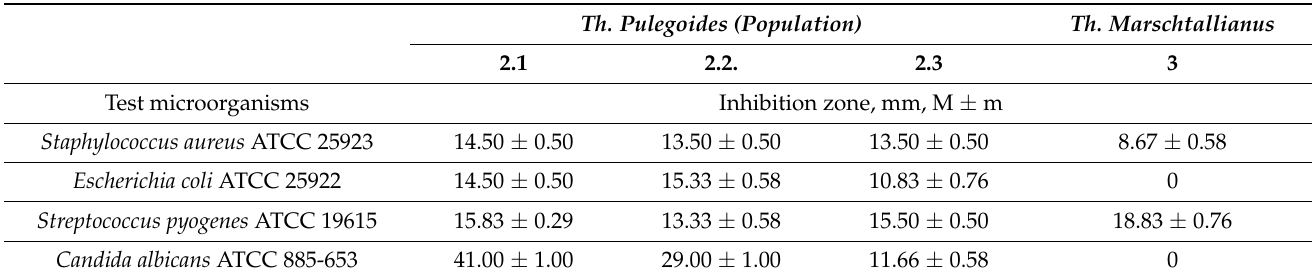
Table 4. Antimicrobial and fungicidal action of raw materials of species of the genus Thymus from different habitats: inhibition zones, mm, M ± m.